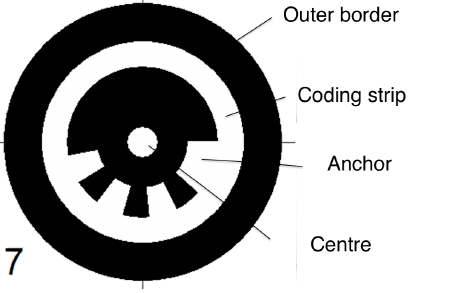
Figure 2. Coded target structure: Outer border serves for elliptic approximation of the target; Coding strip stores the ID of the target; ”Anchor” define the initial position for code reading; Centre can be used for correction of target